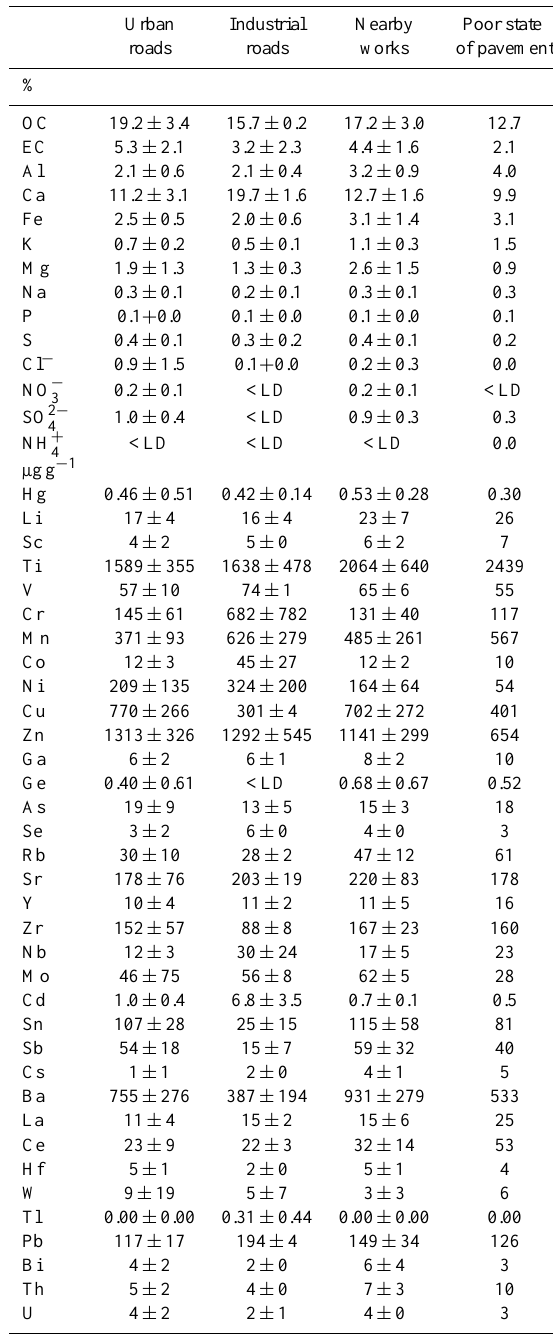
Table 2. Road dust composition averaged per road